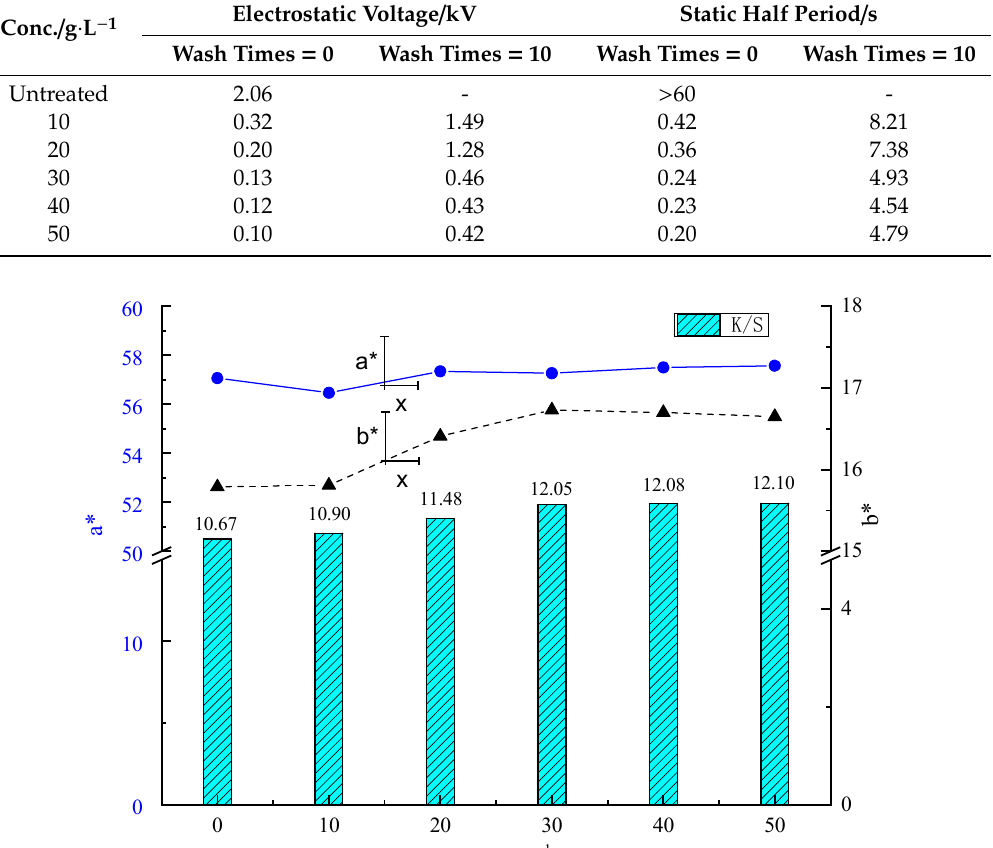
Table 3. Effect of concentration of P[St-BA-F6] on electrostatic voltage and static half period against repeated washings.